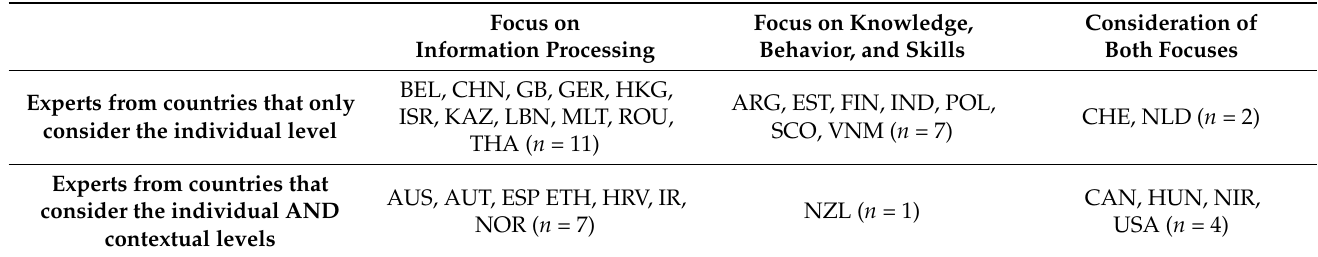
Table 1. Experts from countries that focus information processing and/or knowledge, behavior, and